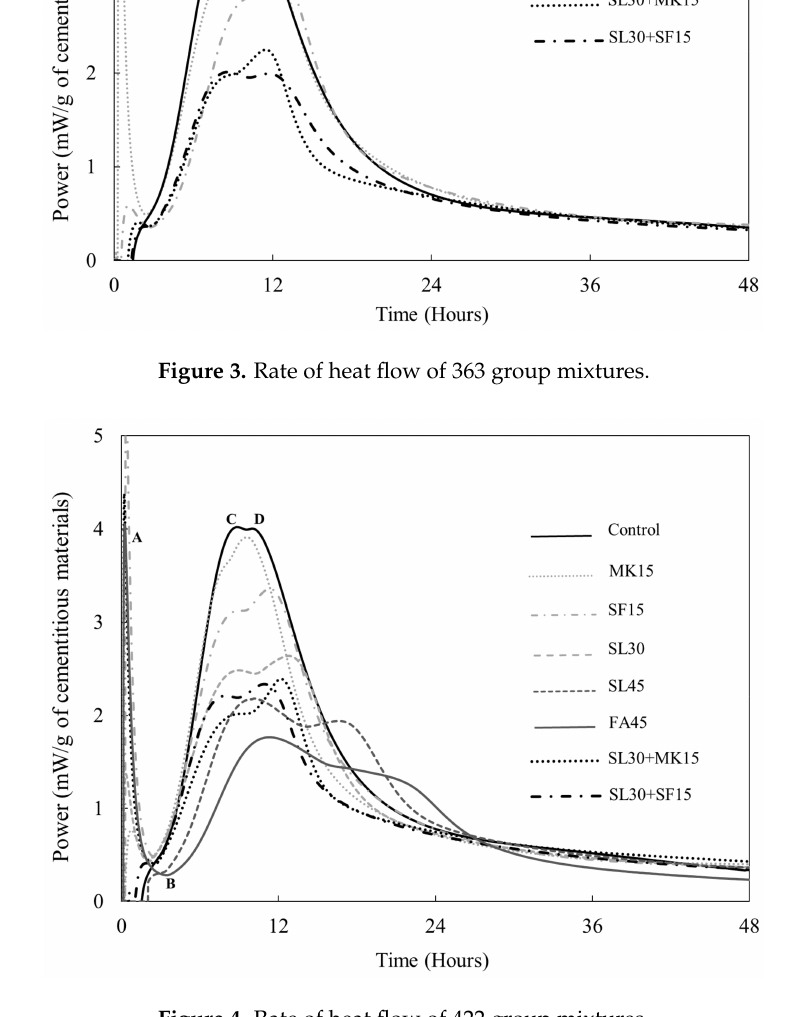
Figure 4. Rate of heat flow of 422 group